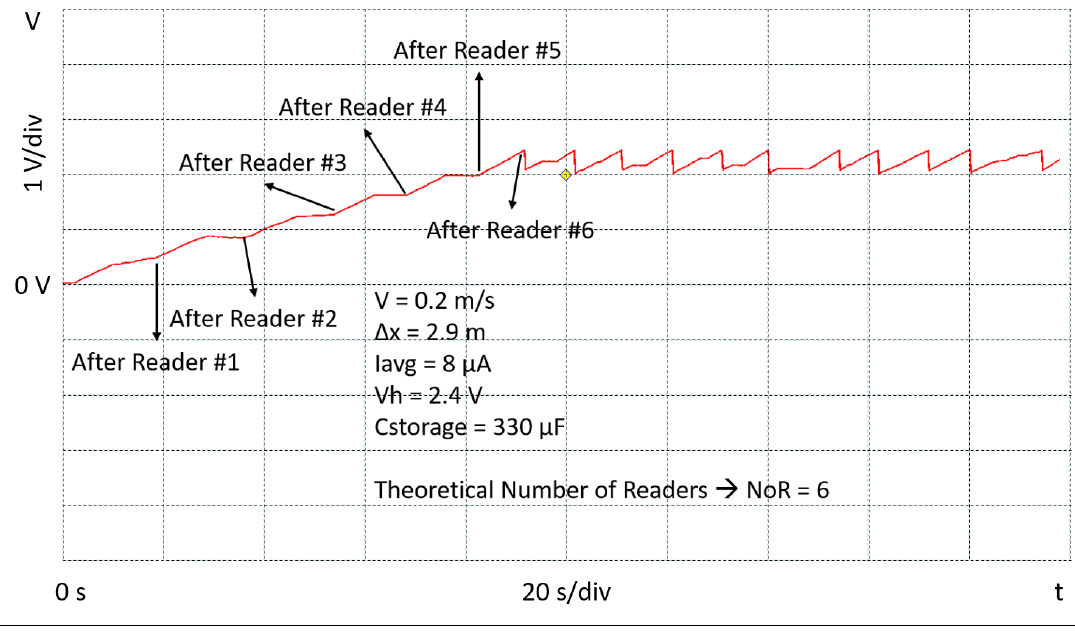
Figure 11. Experimental result of the tag crossing the readers at the speed of 0.2